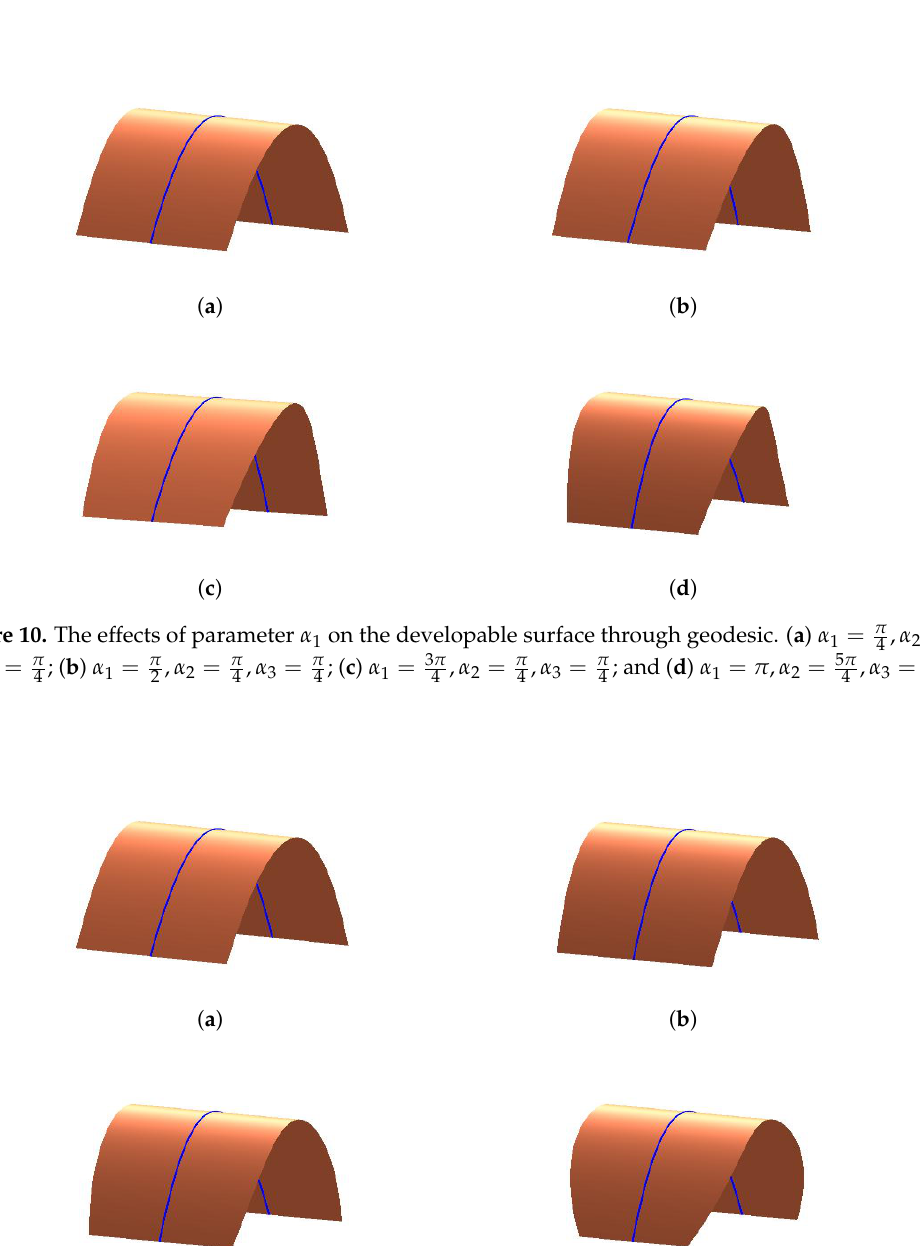
, α 2 = 4 , α 2 = 5 π , α 3 = π 4 4 4